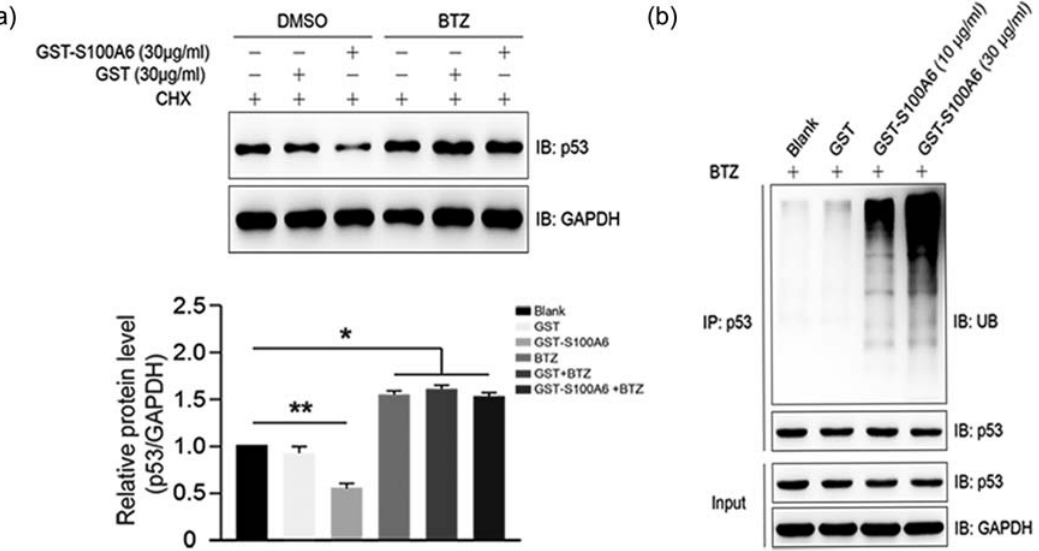
Figure 6: Exogenous S100A6 promotes the ubiquitination of P53. ( a ) S100A6 promotes the degradation of P53 through proteasome; HepG2 cells were treated with GST/GST - S100A6 and BTZ ( bortezomib ) ; the protein levels of p53 normalized to GAPDH; * P < 0.05 and ** P < 0.01. ( b ) S100A6 promotes the ubiquitination of P53; HepG2 cells were treated with GST/GST - S100A6 and BTZ ( bortezomib )